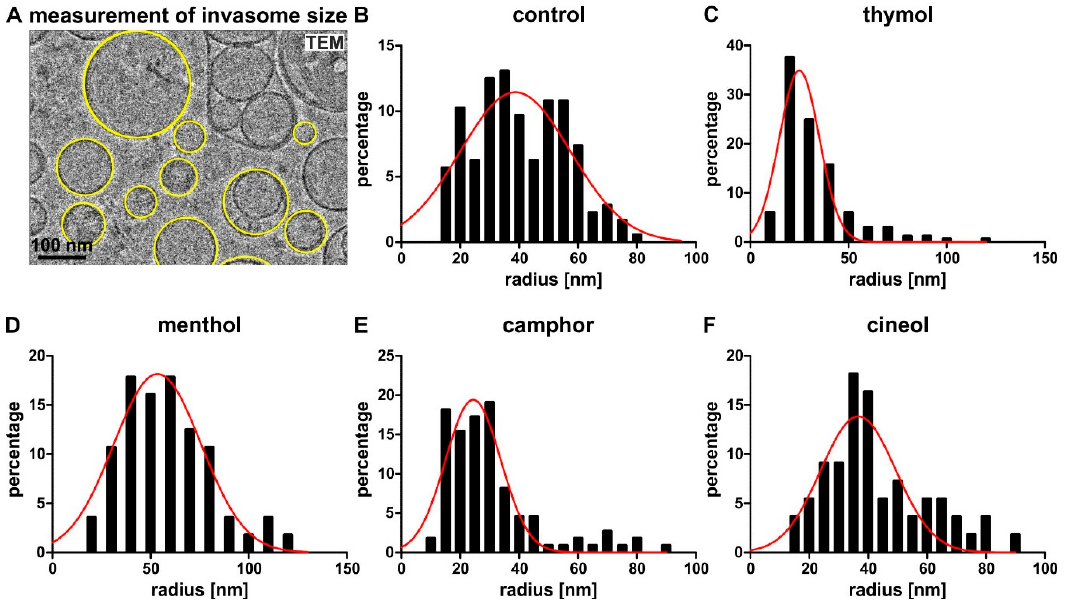
Figure 5. Encapsulation of terpenoids directly affects invasomes size. ( A ) Example of a small representative section of an original cryo-electron micrograph used for measuring invasomes’ size. ( B ) Control invasomes without terpenoid showing a mean radius of 40 ± 15 nm. ( C ) Thymol-comprising invasomes revealed a smaller radius of 33 ± 18 nm compared to control. ( D ) Production of invasomes with menthol resulted in an increased invasome radius of 59 ± 22 nm. ( E ) Like thymol, camphor-invasomes also shower a smaller invasome size (30 ± 16 nm radius) compared to control. ( F ) With a mean radius of 43 ± 17 nm, the size of invasomes with cineol was similar to control. Frequency plots of the radius distribution of the invasomes. A fit with the Gaussian function is displayed as a red line.